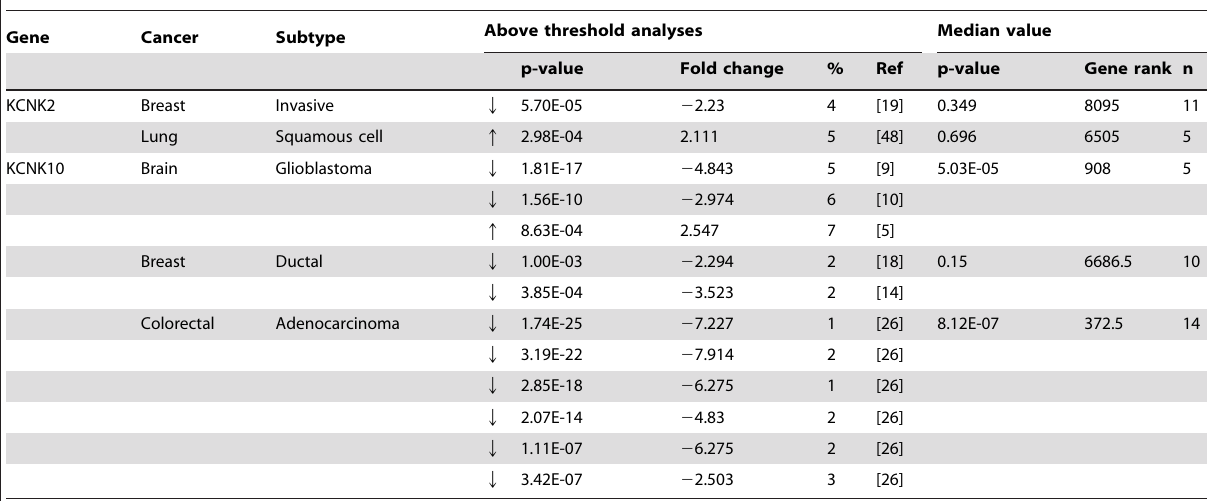
Table 3. TREK family members expression in